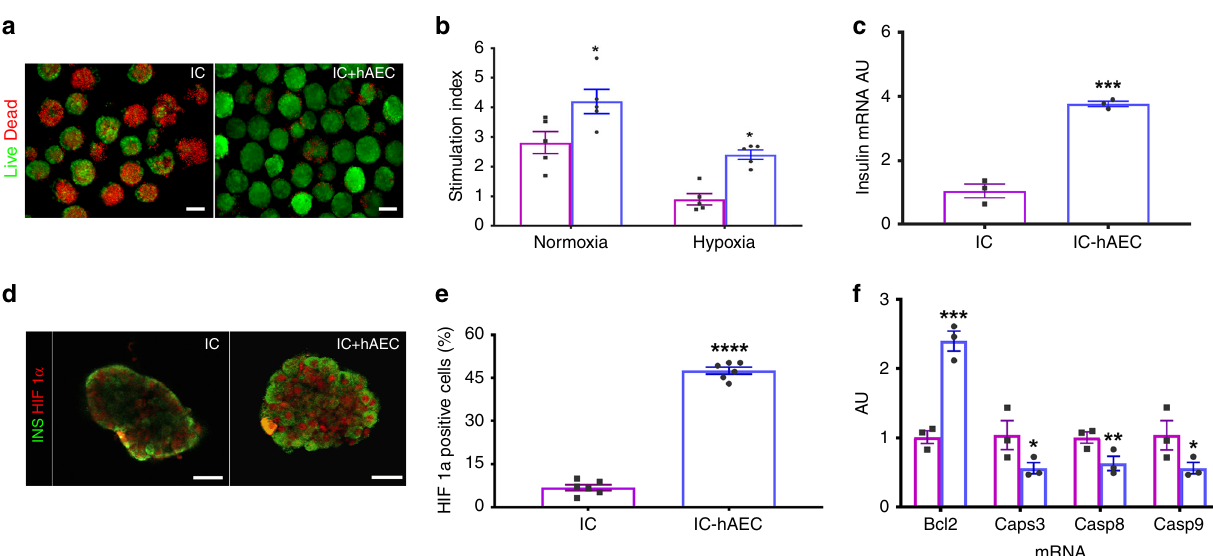
Fig. 3 Organoid functionality after hypoxic stress. a Fluorescence views of IC spheroids and IC-hAEC organoids exposed to hypoxia and assessed for viability by a FDA/PI test; green (FDI) and red (PI) signals indicate live and dead cells respectively. Scale bars = 100 μ m. b Insulin secretion, expressed as SI, of IC spheroids (magenta columns) and IC-hAEC organoids (blue columns) under normoxic and hypoxic conditions, * p < 0.03 and after hypoxic exposure, * p < 0.02, two-way ANOVA with Sidak ’ s multiple comparisons test, n = 5. c Insulin mRNA expressed by IC and IC + hAEC spheroids cultured under hypoxic conditions; insulin mRNA was analyzed by qPCR, and data presented as arbitrary units (AU) after normalization to housekeeping genes, *** p < 0.0003, unpaired Student ’ s t test, n = 3. d , e HIF-1 α nuclear localization visualized by immunostaining and its upregulated expression in IC-hAEC spheroids. **** p < 0.0001, unpaired Student ’ s t test, n = 6. Scale bar = 50 μ m. f Casp3, Casp8, Casp9, and Bcl2 mRNAs expressed by IC spheroids (magenta columns) and IC + hAEC organoids (blue columns) cultured under hypoxic conditions; data presented as arbitrary units (AU) after normalization to housekeeping genes. *** p > 0.0003, ** p < 0.0075, * p < 0.02, unpaired Student ’ s t test, n = 3. All data shown are means±